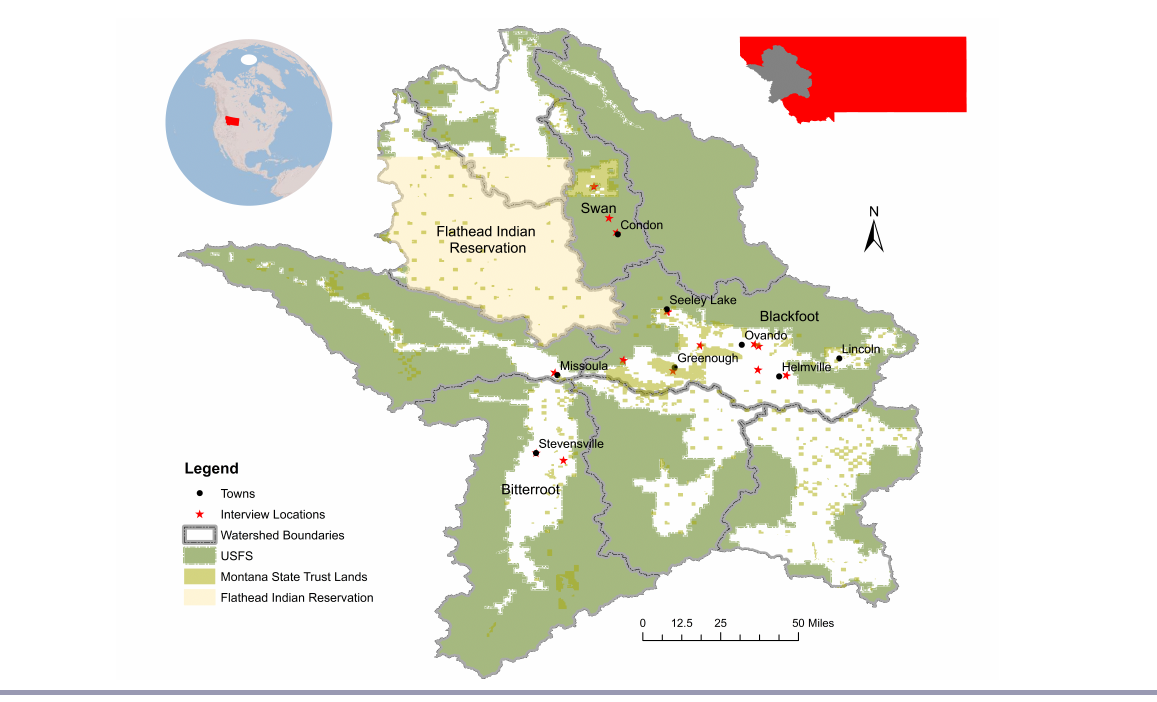
Fig. 1 . Map of case study extent. Top left inset illustrates the location of the state of Montana in North America; top right inset depicts location of study extent with respect to the administrative boundaries of Montana. Watershed boundaries and the distribution of public lands (USDA Forest Service [dark green], Montana State Trust lands [light green]) are illustrated. The location of interviews and local towns within the three watersheds are also depicted. Source: Basemap layers provided by Environmental Systems Research Institute (ESRI), Montana State Trust Lands